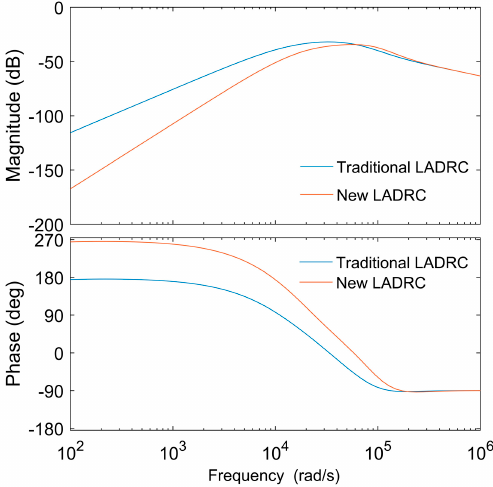
Figure 14. The new LADRC and traditional LADRC anti-disturbance amplitude and phase characteristics.